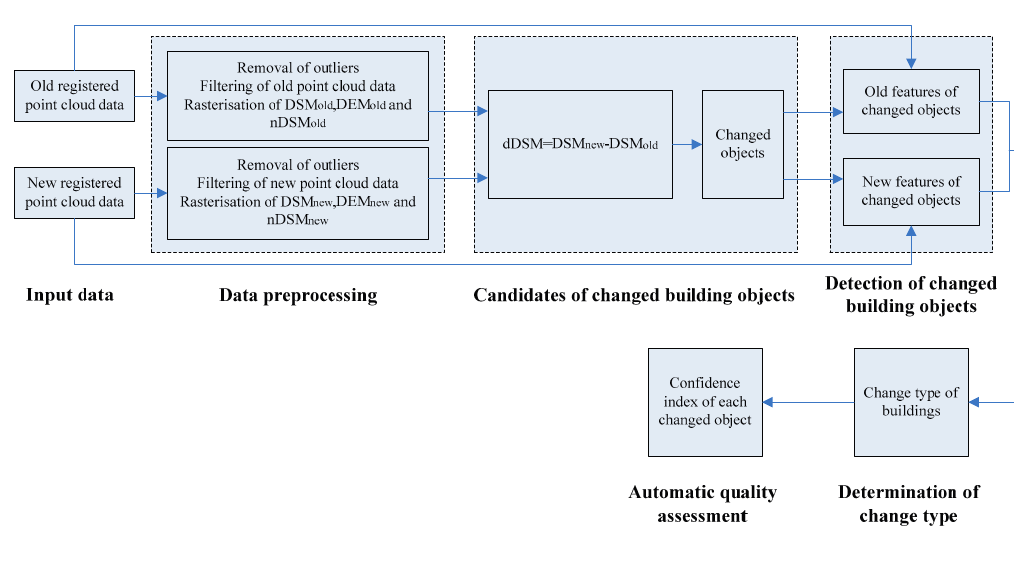
Figure 1. Workflow of the proposed change detection for